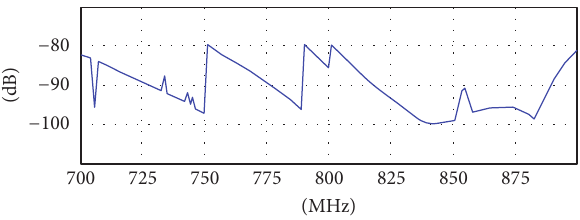
Figure 11: The return figure at the end of the tuning